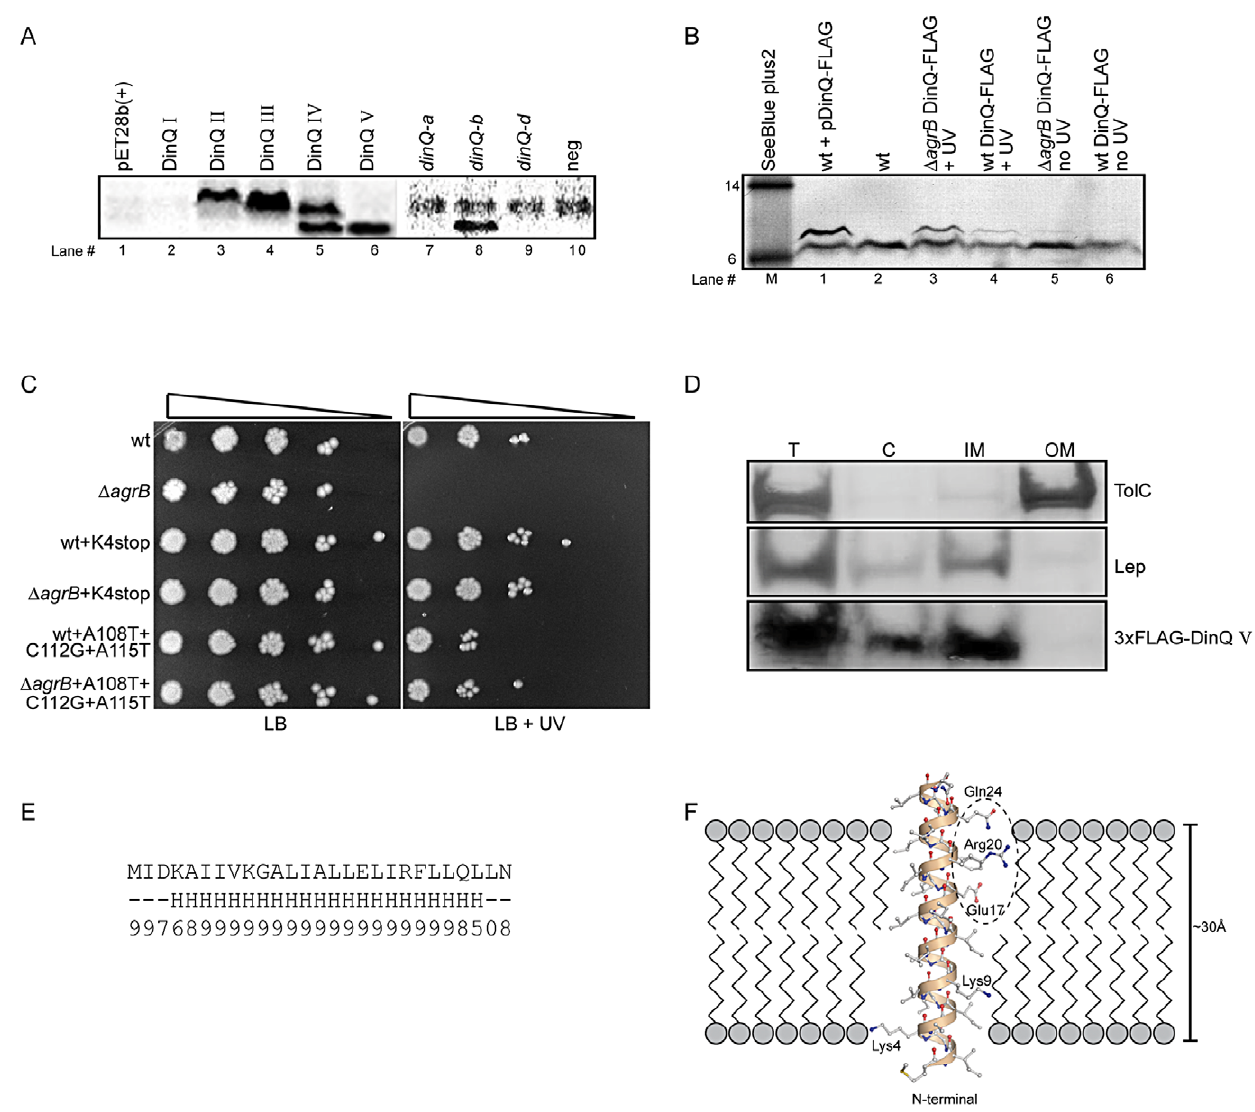
Figure 4. DinQ translation and localization. (A) Translation of putative DinQ peptides I–V expressed from pET28b( + ) plasmid constructs (lanes 1–6) and PCR products corresponding to dinQ-a, -b and -d mRNAs (lane 7–10) were analyzed with coupled in vitro transcription/translation kits from Promega. The E. coli T7 S30 extract system for circular DNA was used to analyze DinQ expression from plasmid constructs while S30 extract system for linear templates was used to analyze PCR products (Promega). Labelling was carried out with [ 14 C]-Leucine. (B) Western analysis of FLAG-tagged endogenous DinQ expression. Protein extracts from UV exposed (20 J/m 2 ) control cells (BK4044) mixed with plasmid pCR2.1-DinQ-3 6 -FLAG in lane # 1 (pos ctrl), wt (BK5300) in lane # 2 (neg ctrl), UV exposed (50 J/m 2 ) D agrB DinQ-3 6 FLAG (BK5372) in lane # 3, UV exposed (50 J/m 2 ) wt DinQ- 3 6 FLAG (BK5370) in lane # 4, unexposed D agrB DinQ-3 6 FLAG (BK5372) in lane # 5, unexposed wt DinQ-3 6 FLAG (BK5370) in lane # 6 was resolved by SDS-PAGE and analyzed by western blotting using Monoclonal ANTI-FLAG M2-Alkaline Phosphatase antibody (SIGMA). Gel migration was monitored relative to SeeBlue Plus2 prestained standard (Invitrogen) in kDa. Detection was carried out by NBT/BCIP color development substrates. The intensities of the DinQ bands was analyzed in three independent western blots with the program ImageJ (Rasband,W.S. and ImageJ, U. S. National Institutes of Health, Bethesda, MD, USA) and normalized against a cross reacting higher molecular weight protein band (not shown in Figure 4B). A cross reacting low molecular protein band of unknown origin is present in all lanes. (C) Serially diluted (10 2 1 –10 2 5 cells ml 2 1 ) log phase cultures of wt (BK5300), D agrB (BK5342), wt dinQ- K4stop (BK5350), D agrB dinQ -K4stop (BK5352), wt dinQ -A108T-C112G-A115T (BK5360) and D agrB dinQ -A108T- C112G-A115T (BK5362) were spotted onto LB plates and exposed to UV (0 J/m 2 and 20 J/m 2 ). Pictures were taken one day after incubation at 37 u C. (D) Subcellular localization of DinQ in wt (ER2566) cells carrying plasmid pET28b( + )-3 6 FLAG-DinQ V. Subcellular fractions was resolved by SDS-PAGE and analyzed by western blotting using antibodies against TolC, Lep and FLAG. Lep and TolC detected inner- and outer membrane proteins, respectively. T: total protein; C: cytoplasmic fraction; IM: inner membrane fraction; OM: outer membrane fraction. (E) DinQ amino acid sequence with predicted secondary structure elements (H=helix, ‘-’=other) and corresponding reliability index (range 0–9). (F) 3D modelling of DinQ as a regular a - helix embedded in a lipid membrane. Polar patch formed by residues Glu17, Arg20 and Gln24 encircled by dashed ellipse. doi:10.1371/journal.pgen.1003260.g004 was restored to wild type level in the agrB mutant (Figure 4C), three chromosomal point mutations in the dinQ up-stream indicating that the UV sensitivity of the agrB mutant is caused by sequence predicted to be involved in base pairing with agrB translation of a functional DinQ peptide. Next, we introduced (Figure 3C, bases labeled in red). Exposure of these strains to UV